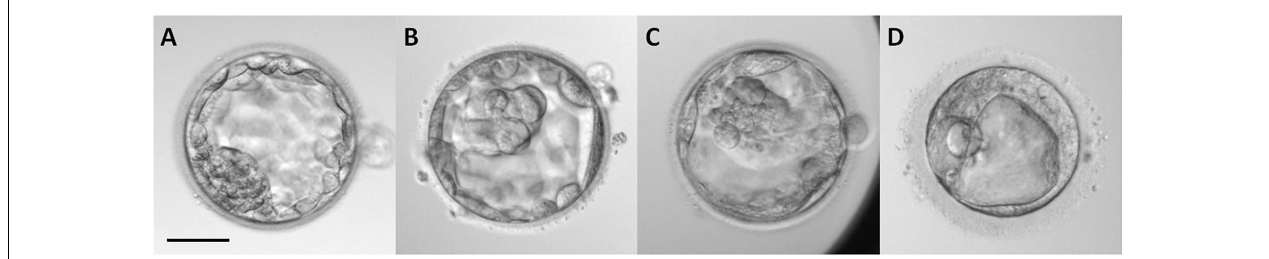
FIGURE 1 | Morphological classification of blastocysts in day 5 of in vitro development according to the criteria established by the Spanish Association for the Study of the Biology of Reproduction (ASEBIR) based on the morphological evaluation of the inner cell mass (ICM) and trophectoderm (TE) (Hurtado de Mendoza et al., 2015; Cuevas Saiz et al., 2018). The implantation potential of blastocysts according to this classification is established as follows: grade (A) , maximum; grade (B) , high; grade (C) , medium; grade (D) , low (see Table 1 ). Scale bar represents 25 µ m. TABLE 1 | Spanish Association for the Study of the Biology of Reproduction (ASEBIR) scoring for blastocyst stage in day 5 of embryo development according to morphological evaluation of the inner cell mass (ICM) and trophectoderm (TE) (Hurtado de Mendoza et al., 2015; Cuevas Saiz et al., 2018). Inner cell mass (ICM) Trophectoderm (TE) Embryo quality Potential of